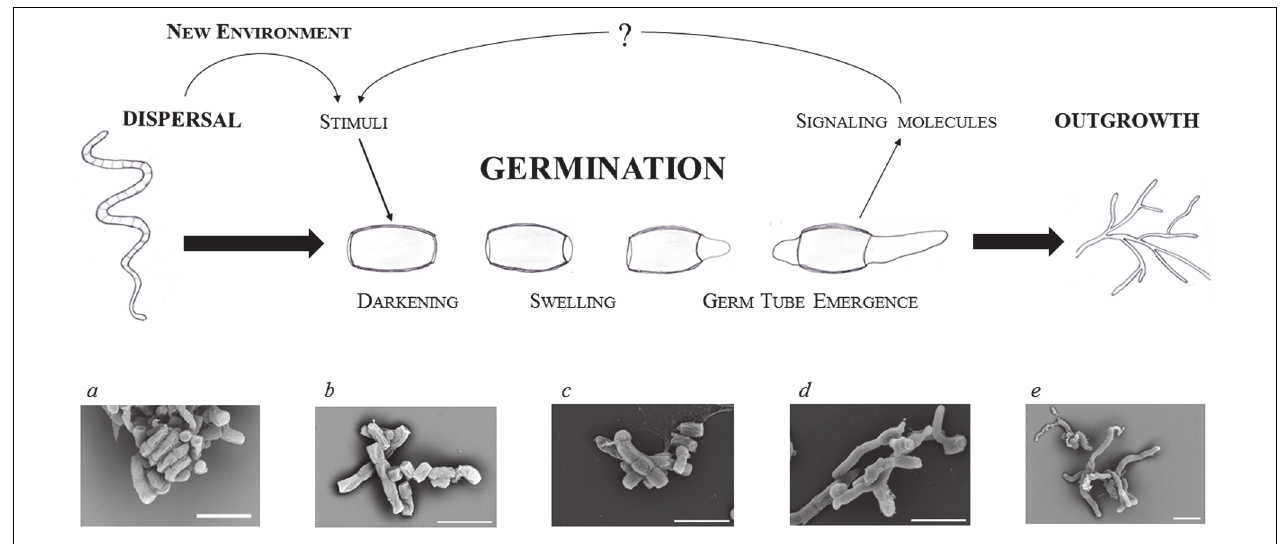
FIGURE 1 | Focus on streptomycete spore germination. Schematic illustration of a germinating spore and electron microscopic images of dormant (a,b) and germinating (c–e) spores of S. coelicolor : residue of an aerial hypha with a twisted chain of matured spores (a); dormant spores (b); time-lapse imaging of germinating spores after 2, 4, and 6 h of cultivation (c–e, respectively) in a complex medium (for details see ˇCihák et al., submitted). The white bars indicate 2.5 µ